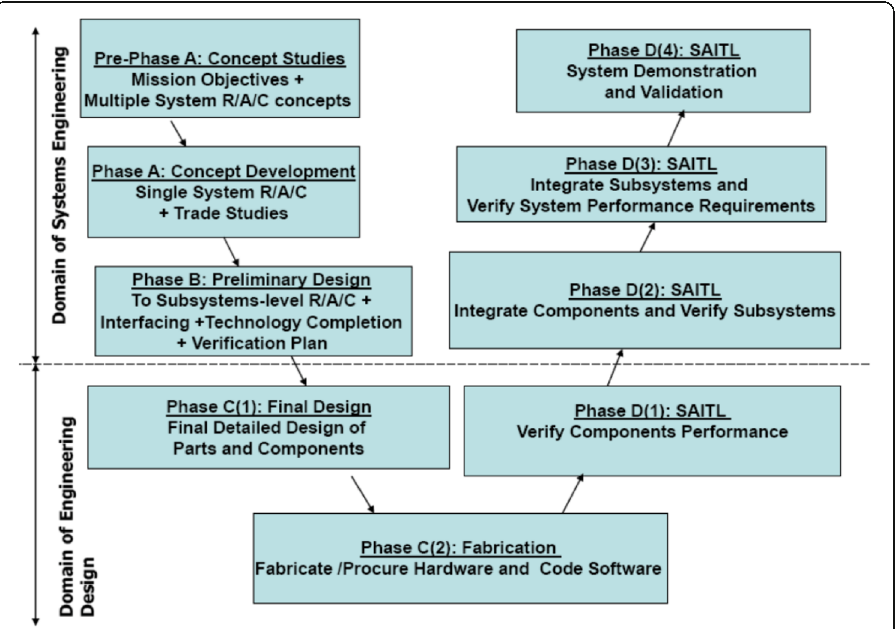
Fig. 1 Vee diagram in the single systems engineering formula by NASA (NASA